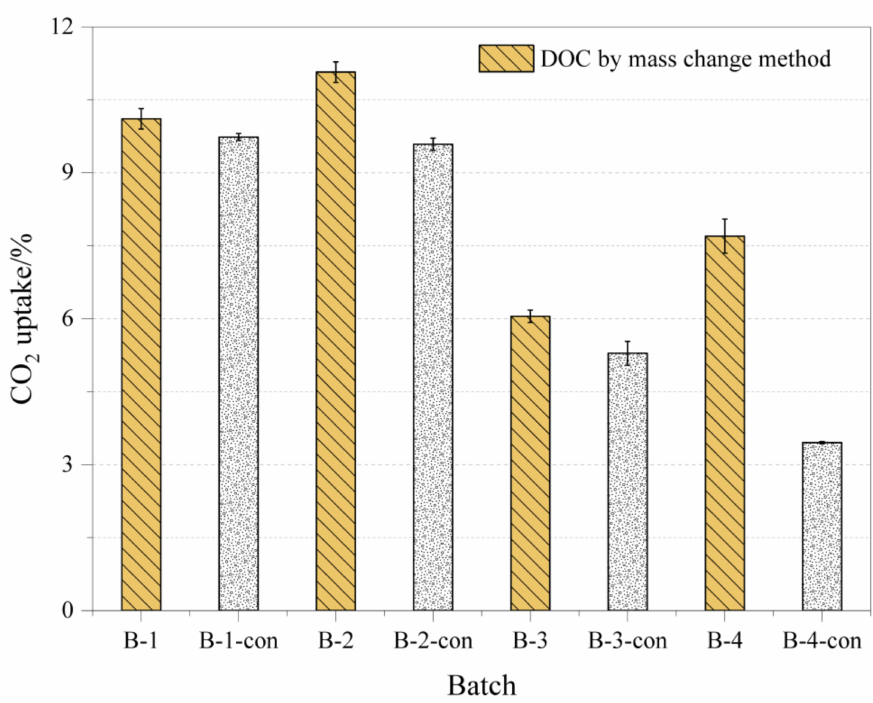
Figure 3. CO 2 uptake by mass change